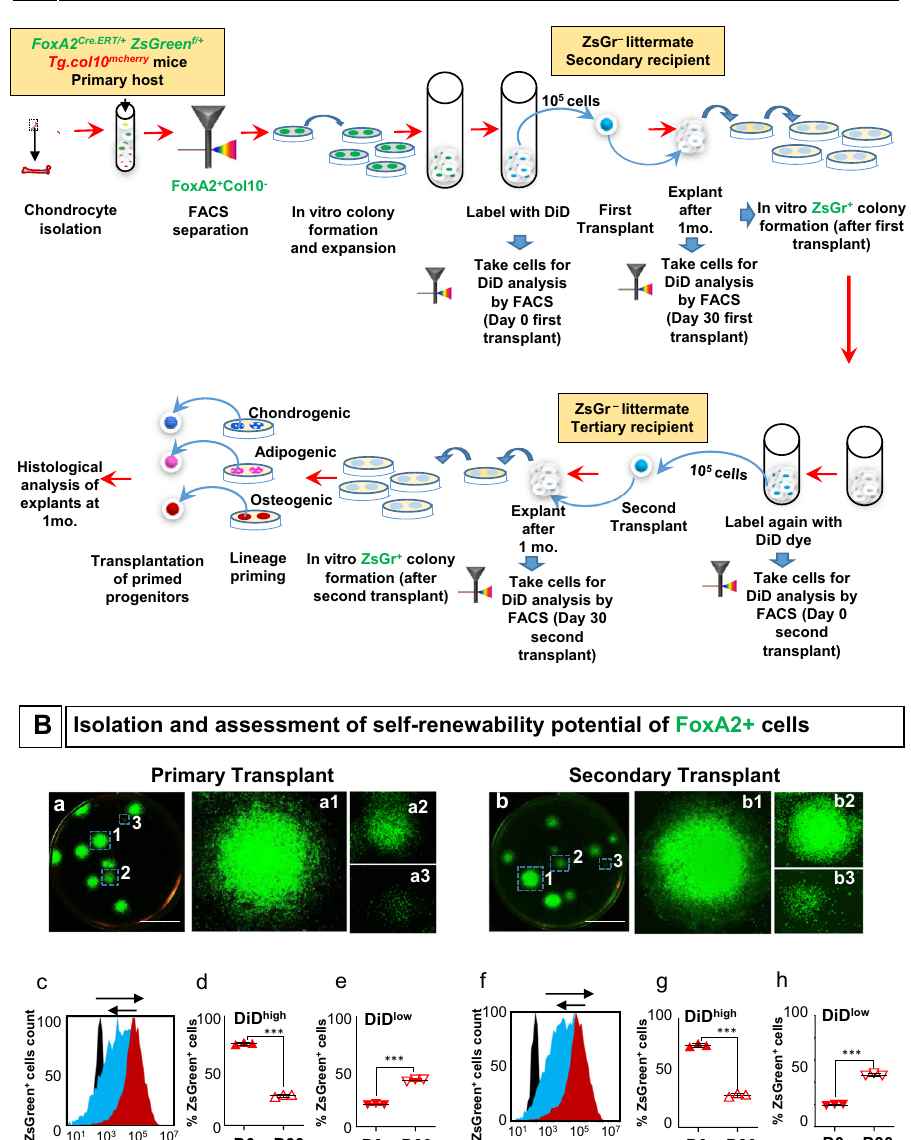
Fig. 5 Serial transplantation of FoxA2 + cells in vivo. A Experimental strategy for the isolation and assessment of self-renewability and differentiation potential of FoxA2 + cells in vivo. B Representative images of colonies derived from FoxA2 + cells isolated from primary ( a ) and secondary transplants ( b ). Scale bars, 1 cm. DiD fl uorescence intensity histogram pro fi les at Day 0 (red), Day 30 (blue), and negative control (black) from primary ( c ) and secondary ( f ) transplants. Percentage of DiD high cells in the FoxA2 + cells from primary ( d ) and secondary ( g ) transplants. Percentage of DiD low cells in the FoxA2 + cells from primary ( e ) and secondary ( h ) transplants. Data are presented as mean ± SD for each group, n = 3 mice. The asterisks indicate signi fi cant difference: two-tailed Student ’ s unpaired samples t test; *** p = 7.0148E − 07 (DiD high primary transplant D0 vs D30), 7.84512E − 06 (DiD low primary transplant D0 vs D30), 3.32176E − 06 (DiD high secondary transplant D0 vs D30), and 3.46695E − 06 (DiD low secondary transplant D0 vs D30). Complete statistical information is provided in Supplementary Table FoxA2 + cells contribution to the epiphyseal bone slows down subcutaneously into ZsGreen- littermates (Fig. 5A, Supplemen- signi fi cantly after P28 (Supplementary Fig. 6A2). tary Fig. 7A). After 1 month, FoxA2 + (ZsGreen + ) cells from the grafts exhibited self-renewability and retained colony-forming ability (Fig. 5B(a)). In addition, the grafted cells have undergone multiple rounds of cell division shown by a log-fold reduced Self-renewability of FoxA2 + cells in a reconstitution assay . To fl uorescence, observed as a shift in the intensity histogram plots demonstrate self-renewal and multipotent capabilities of FoxA2 + (Fig. 5B(c)). Peak DiD intensity at day 0 (D0), immediately before cells in vivo, we performed a serial transplantation assay. We transplantation, was 1.2 × 10 4 , and it was reduced to 1.1 × 10 3 on isolated FoxA2 + (ZsGreen + ) cells from FoxA2 CreERT2/ + ; day 30 (D30) post-transplantion (Fig. 5B(c)). The percentage of ZsGreen fl / + ;Tg.col10 mCherry mice, as previously described, labeled ZsGreen + cells with high intensity DiD fl uorescence (DiD high ) them with DiD fl uorescent dye, and transplanted them